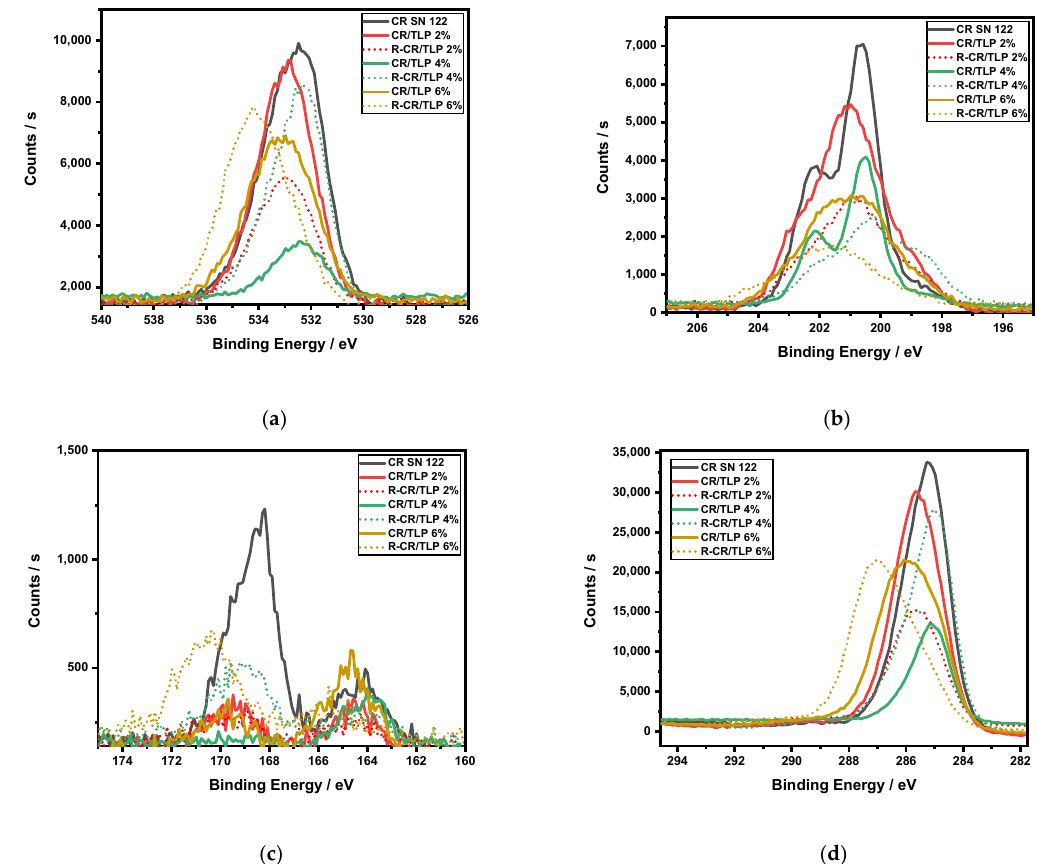
Figure 5. XPS data comparison between CR SN 122, TLP, cured compounds and recycled compounds: ( a ) O 1s spectra; ( b ) Cl 2p; ( c ) S 2p; ( d ) C 1s.